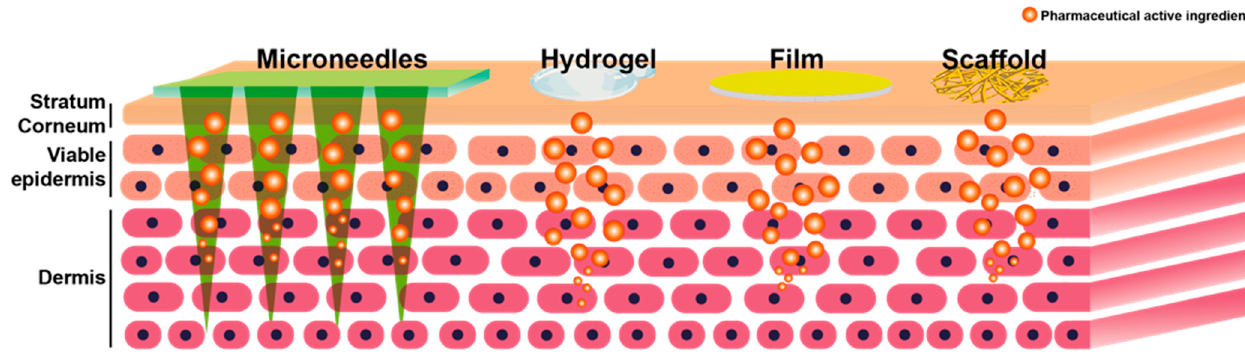
Figure 1. Four types of polysaccharide-based vehicles in transdermal drug delivery.